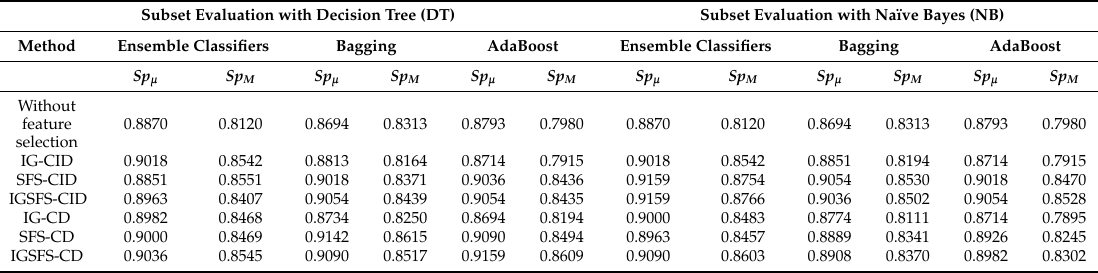
Table 6. Specificity comparison using micro-averaging and macro-averaging methods with ensemble learning methods for